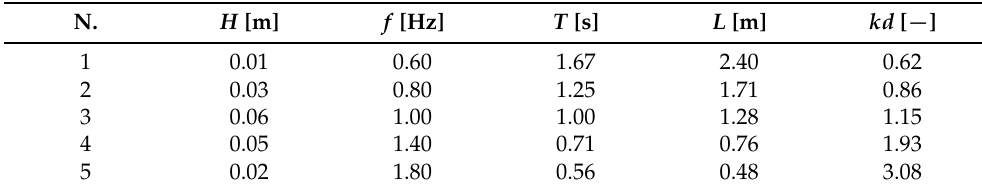
Table 1. Wave characteristics close to the model (where the symbols indicate: H wave height, f wave frequency, T wave period, L wavelength, k = 2 π wave number, and d water depth). The wavelength L was estimated through the dispersion